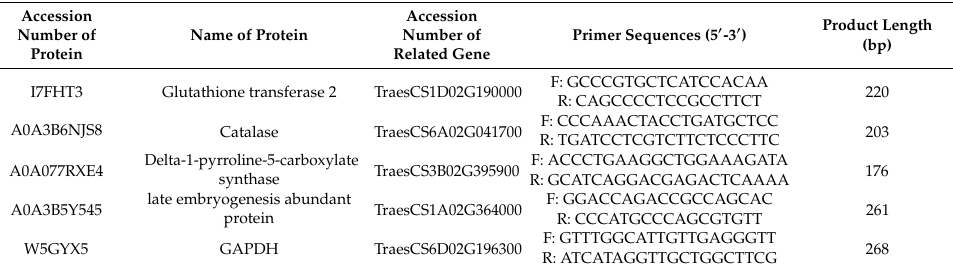
Table 2. The primer sequences used in